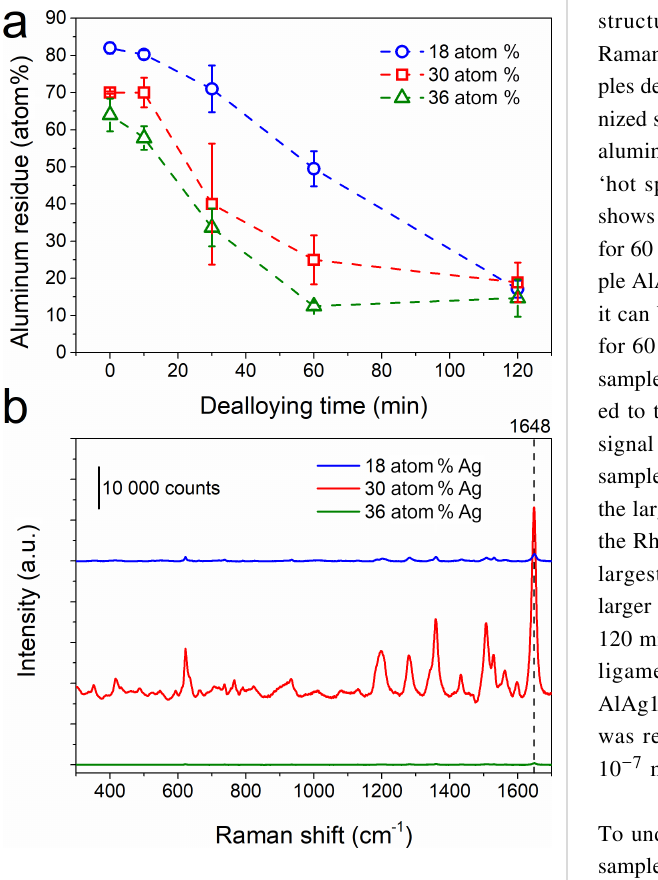
Figure 4: (a) Aluminium content evaluated by EDX for samples de- alloyed in 1 wt % of HCl and for an initial Ag content of 18, 30, and 36 atom % in the film. (b) Raman spectra recorded after 24 h of incu- bation in a 10 − 7 mol·L − 1 solution of RhB on a nanoporous silver film obtained after 60 min of dealloying in an HCl solution with an initial composition of 18, 30, and 38 atom